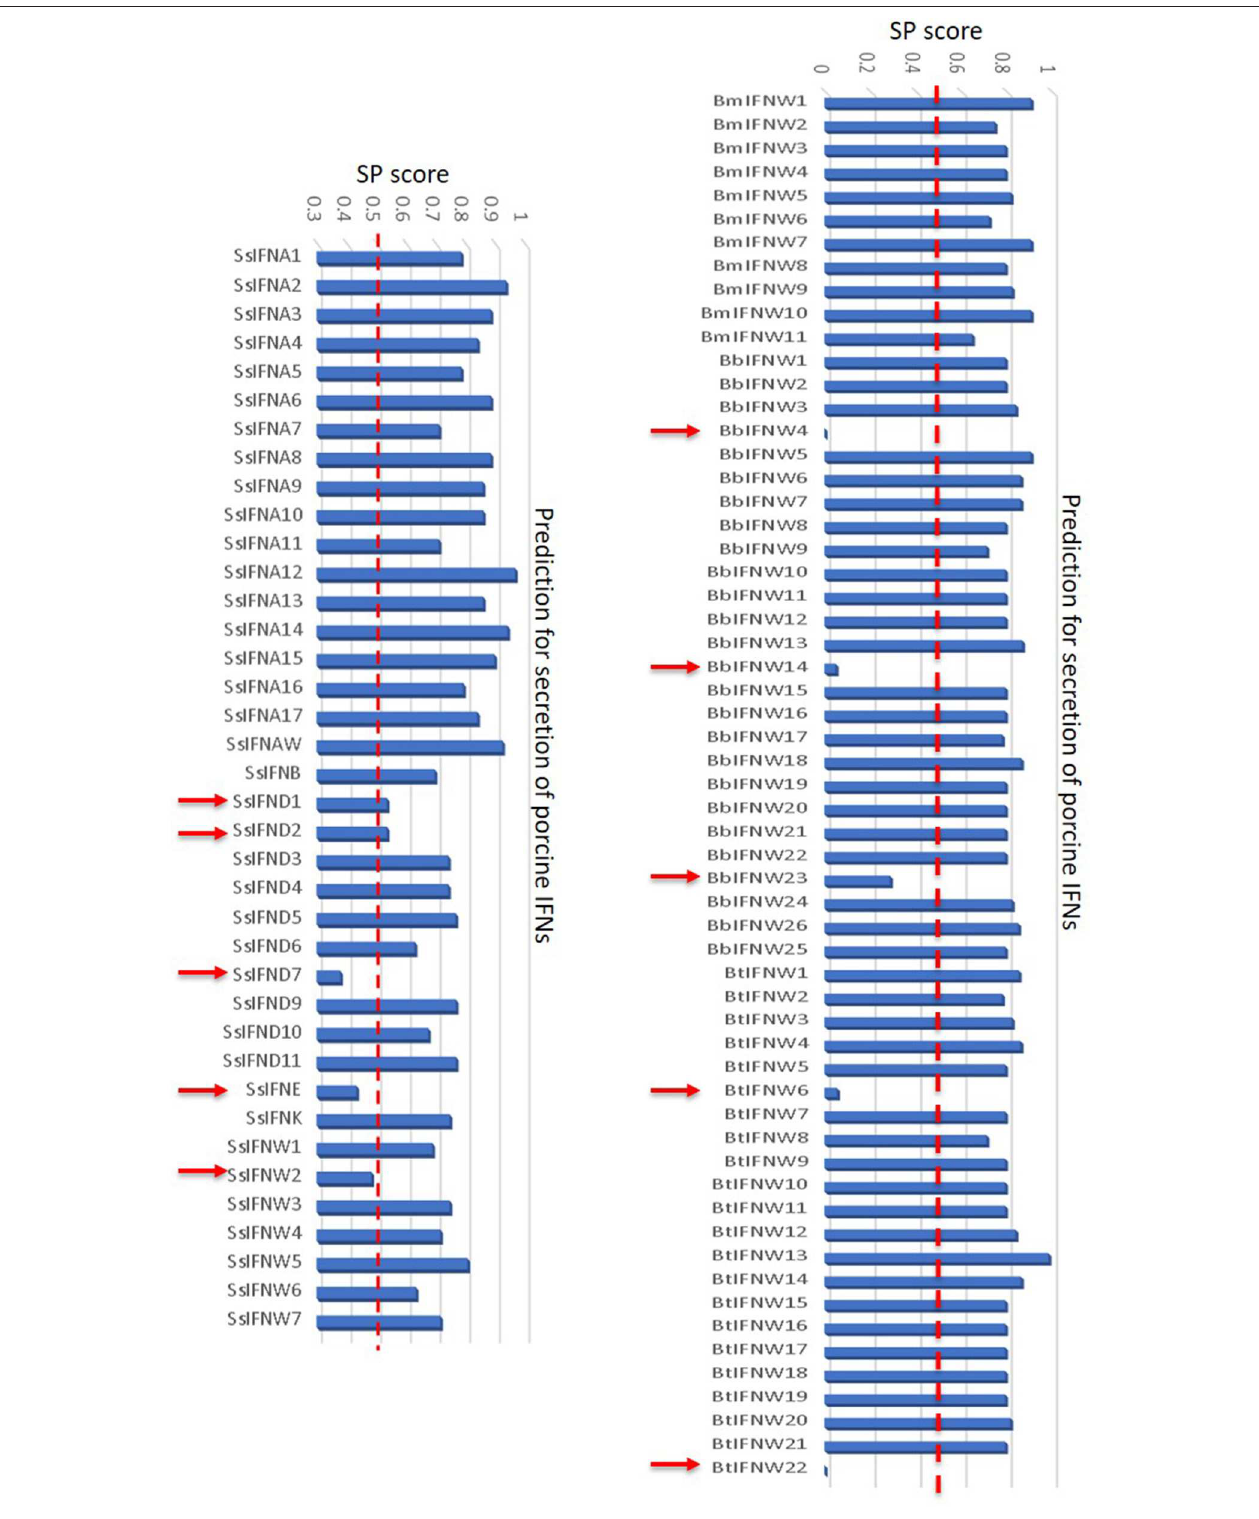
FIGURE 10 | Signal peptides of swine and bovine IFN peptides were examined using PrediSi (http://www.predisi.de) to determine the secretory potency of relevant IFN mature peptides, indicating the evolution of intracellular IFNs (indicated by arrows, signal peptide prediction score 0–0.5) in each subgroup, particularly of unconventional IFN subtypes such as IFN- δ and IFN- ω subtypes that undergoing multi-gene expansion such as in pigs and cattle (2, 9).